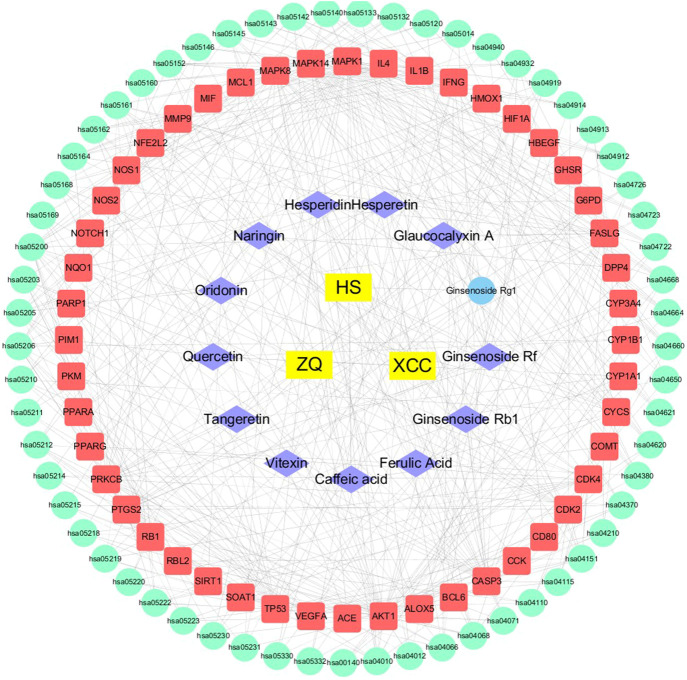
Pharmacology-network of the “origins-components-targets-pathways” regulated by WFC. The yellow rectangles represent Chinese herbal medicines, while the purple rhombuses represent active components of WFC. The blue ellipse represents metabolites of ginsenoside Rg1. The red rectangles represent target proteins, and the green ellipses represent pathways in Table 6.